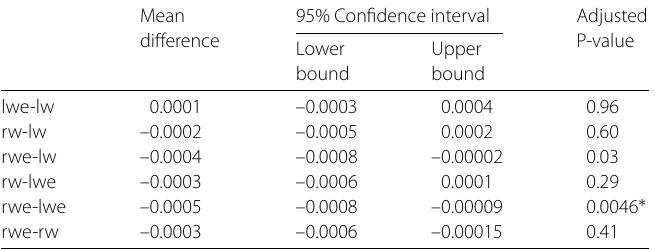
Table A7 Multi-group mean comparisons of fairness in 25% sample size data using Tukey’s HSD test Mean 95% Confidence interval Adjusted difference P-valueLower Upper bound bound lwe-lw